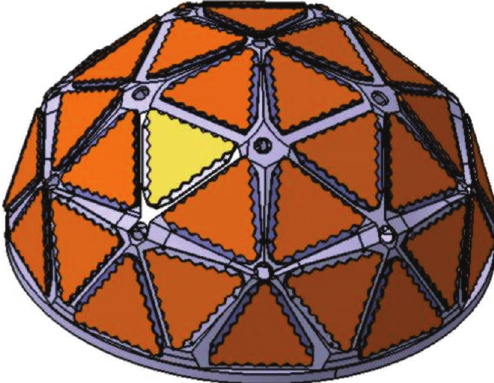
Figure 14: Assembled Hemi-Spherical antenna.